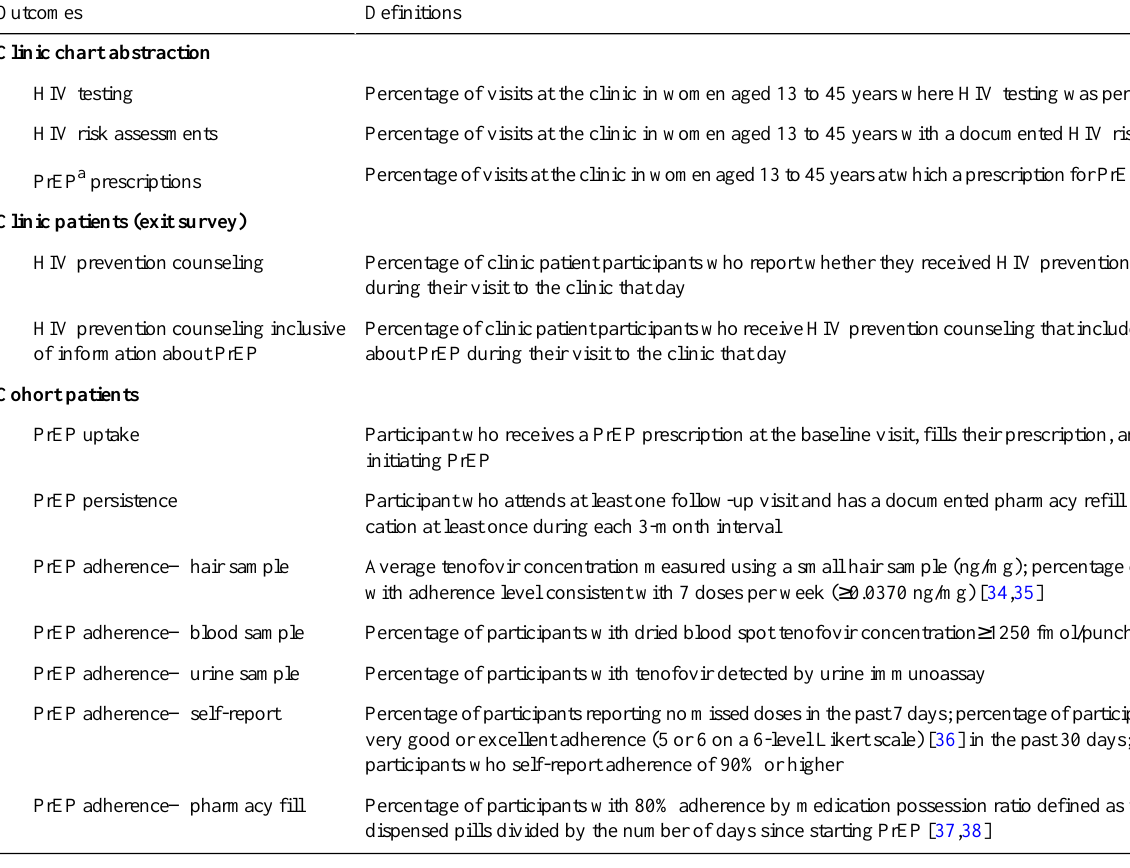
Table 2. Description of outcomes supporting the study’s primary objective to describe the HIV pre-exposure prophylaxis care cascade among women aged 13 to 45